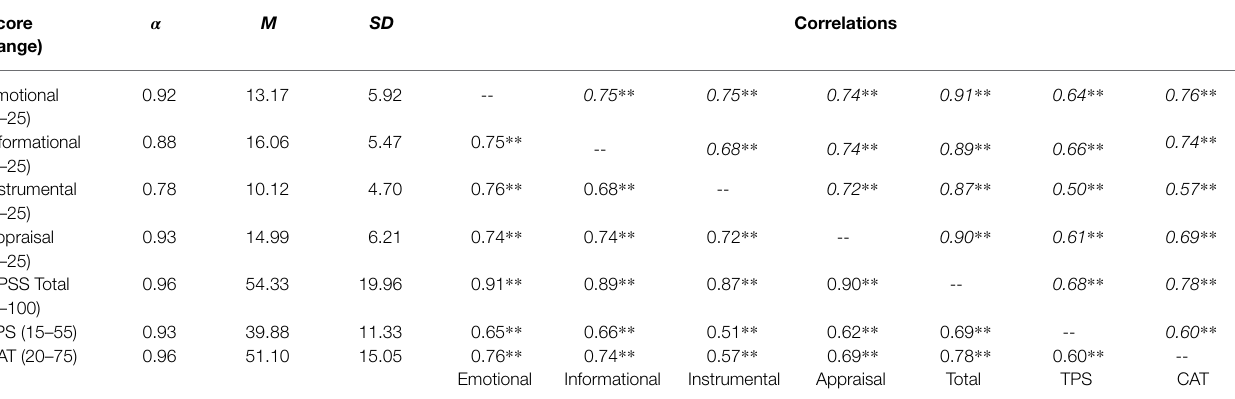
TABLE 6 | Descriptive statistics and intercorrelations among HPSS scores, trust in physician, and physician’s communication skills. Score α M (range)